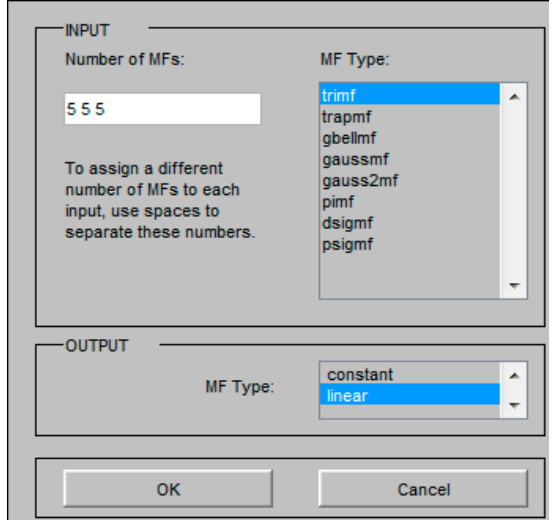
Figure 3. Partitioning of the membership functions of the input parameters and the membership function of the output parameter.